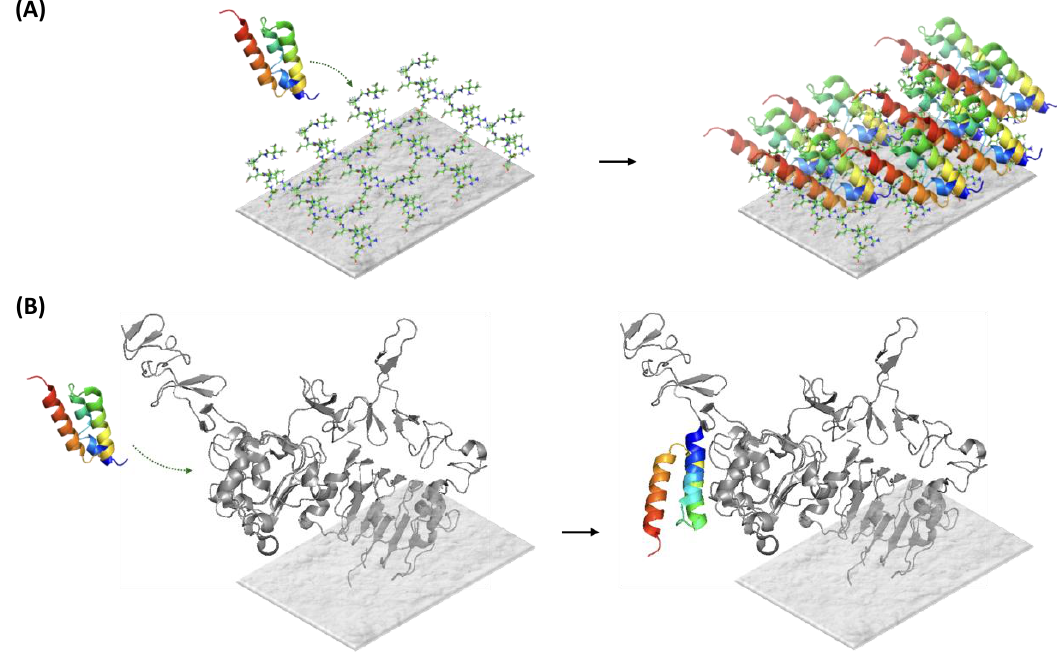
Figure A3. Representation of affibody binding on ( A ) IGKQRI–GSG–Toyopearl vs. ( B ) erbB2–Toyopearl resins. The peptide ligands, target affibody, and protein–affibody complex are in 1:1 molecular scale to each other.